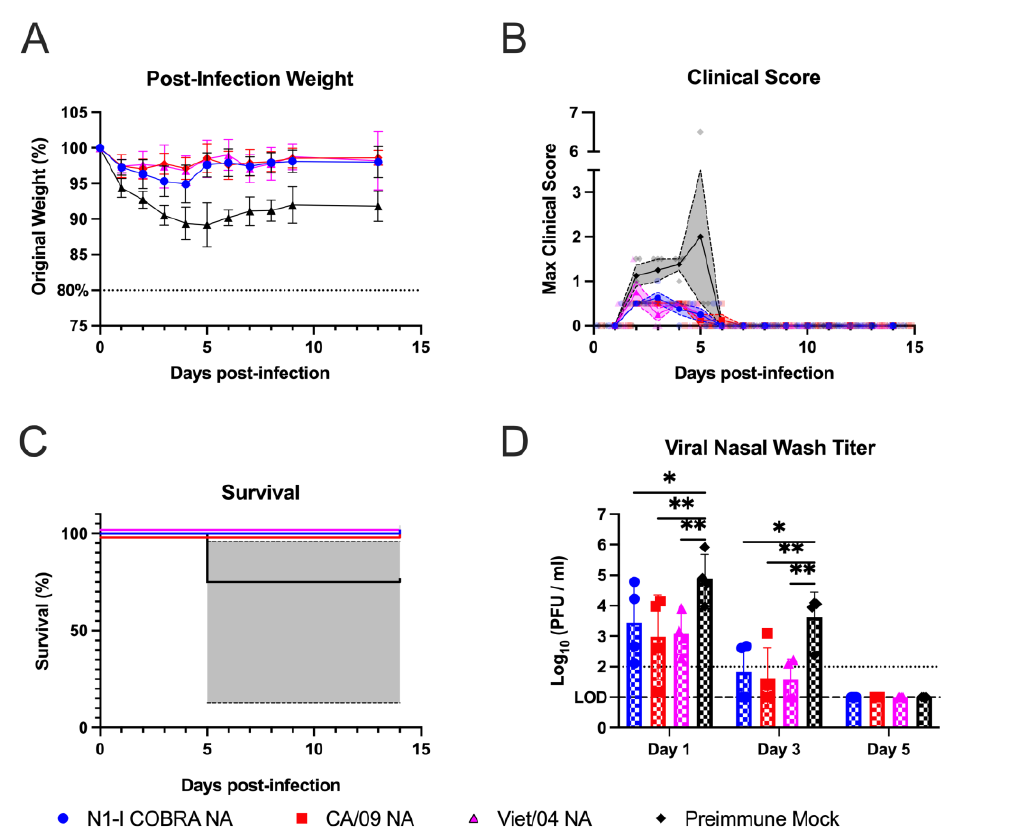
Figure 4. NA-vaccinated ferrets pre-immunized with Sing/86 H1N1 exhibited minimal clinical signs after intranasal infection with CA/09 H1N1. ( A ) After infection with CA/09, the weight during infection was normalized to the percentage of the original starting weight before infection. ( B ) The maximum clinical scores from the morning and evening checks were displayed with a score of three or greater indicating clinical endpoint. Individual ferret clinical scores are shown with the line connecting the mean score and the range of the standard error of the mean shaded. ( C ) The survival percentage for each group was determined. The 95% asymmetrical confidence intervals are shown as shadow for the groups that did not have 100% survival. ( D ) The nasal wash titers for all vaccinated groups were determined through plaque assay. The limit of detection (LOD; dashed line) was 1.0 log 10 (PFU/mL), and the limit of quantification (dotted line) was 2.0 log 10 (PFU/mL). A two-way repeated measures ANOVA and Dunnett’s test for multiple comparisons was used for statistical analysis with the mock-vaccinated as the control group. All error bars represent standard deviation. The minimum weight before clinical endpoint was 75%, with 80% denoting an increase in clinical scoring. Adjusted p-value: * ≤ 0.05, ** ≤ 0.01.